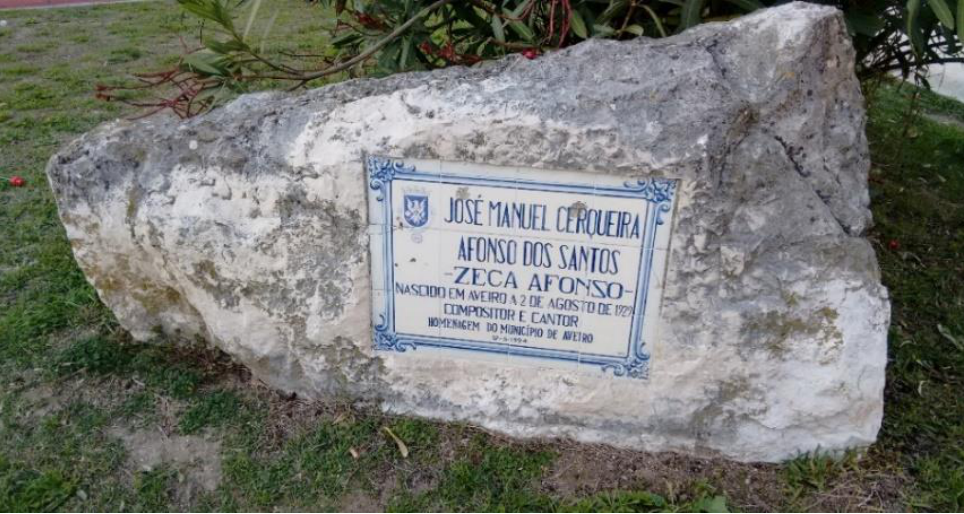
Figure 8. Station 5 overview, where it is possible to see limestone with a dirty